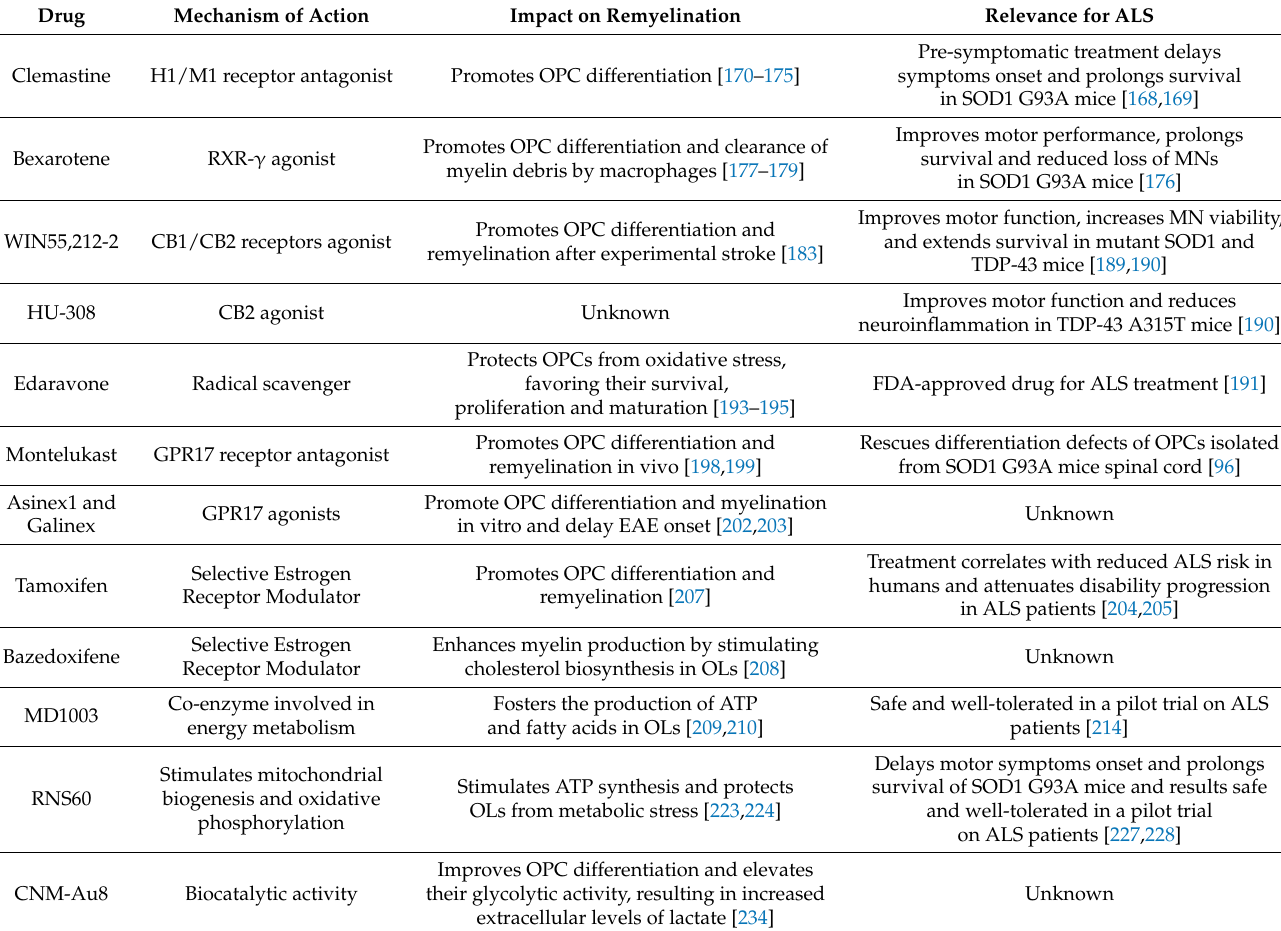
Table 1. Promising candidate drugs to counteract OL dysfunction in